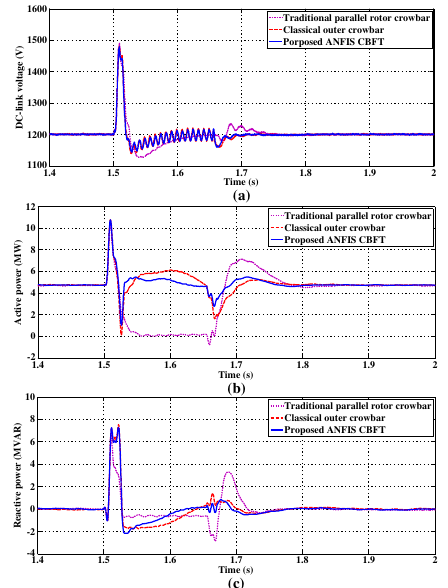
Fig. 10 Comparison of measured values for traditional, classical, and proposed protection techniques during double-phase to ground fault ( a ) DC-link voltage; ( b ) active power; ( c ) reactive power